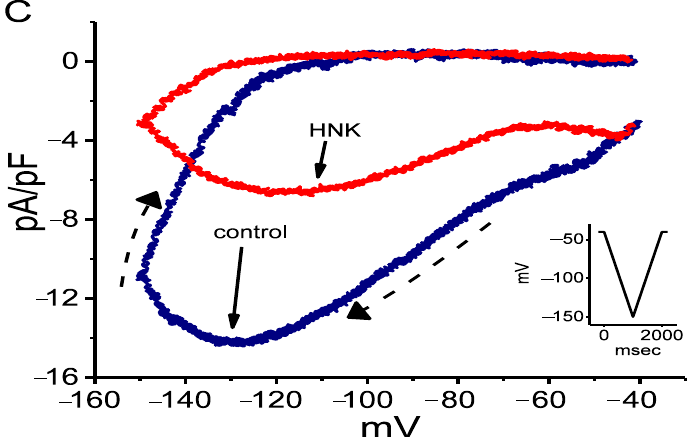
Figure 3. The e ff ect of HNK on the voltage-dependent hysteresis taken from GH 3 cells. ( A ) Representative I h density elicited by 2-s triangular (i.e., upsloping and downsloping) ramp pulse between − 150 and − 40 mV. Inset in the right lower corner in ( A ) is the voltage protocol applied during the recordings. The voltage hysteresis (i.e., forward or reverse current versus voltage relationship) of I h density was detected in the absence and presence of 3 µ M HNK. The dashed arrow in ( A ) denotes the direction in which time passes. ( B ) Summary bar graph showing the e ff ect of HNK, HNK and oxaliplatin (OXAL) on the ∆ area (as indicated in shaded area in ( A )) of voltage hysteresis (mean ± SEM; n = 8 for each bar). ∆ Area taken with or without addition of HNK is indicated as shaded area in ( A ). * Significantly di ff erent from control ( p < 0.05) and † significantly di ff erent from HNK (3 µ M) alone group ( p < 0.05). ( C ) Representative I h density in response to 2-s triangular (downsloping and upsloping) ramp pulse obtained in the absence and presence of 3 µ M HNK. Inset is the triangular pulse applied, and the dashed arrow indicates the direction in which time passes.